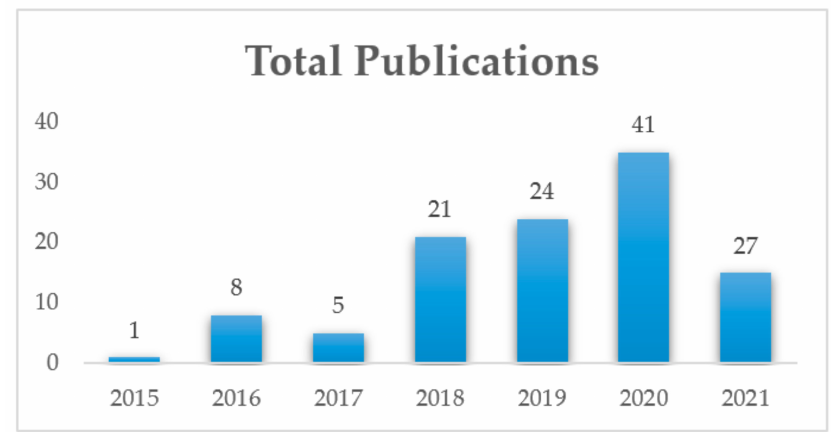
Figure 2. Year-wise publication in Industry 4.0 and sustainability.